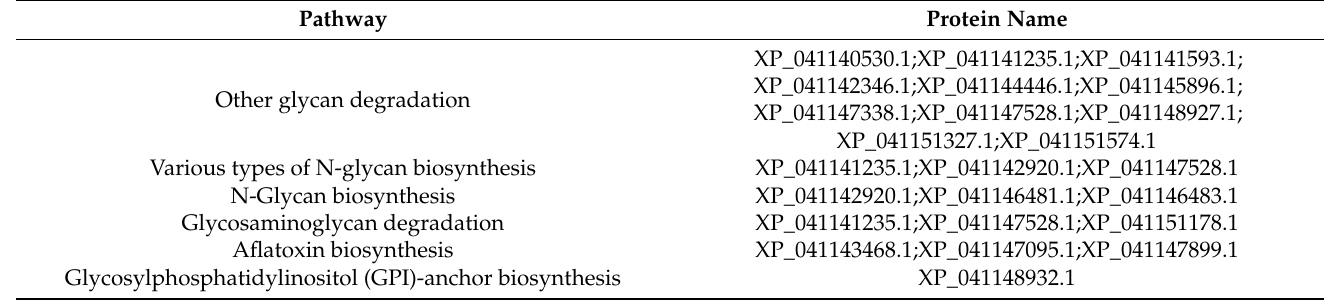
Figure 4. Identification and annotation of A. flavus surface proteins. ( A ) Protein count. ( B ) KOG analysis. ( C ) GO analysis ( D ) KEGG annotation. Table 2. Proteins and the pathways involved in cell wall construction and aflatoxin